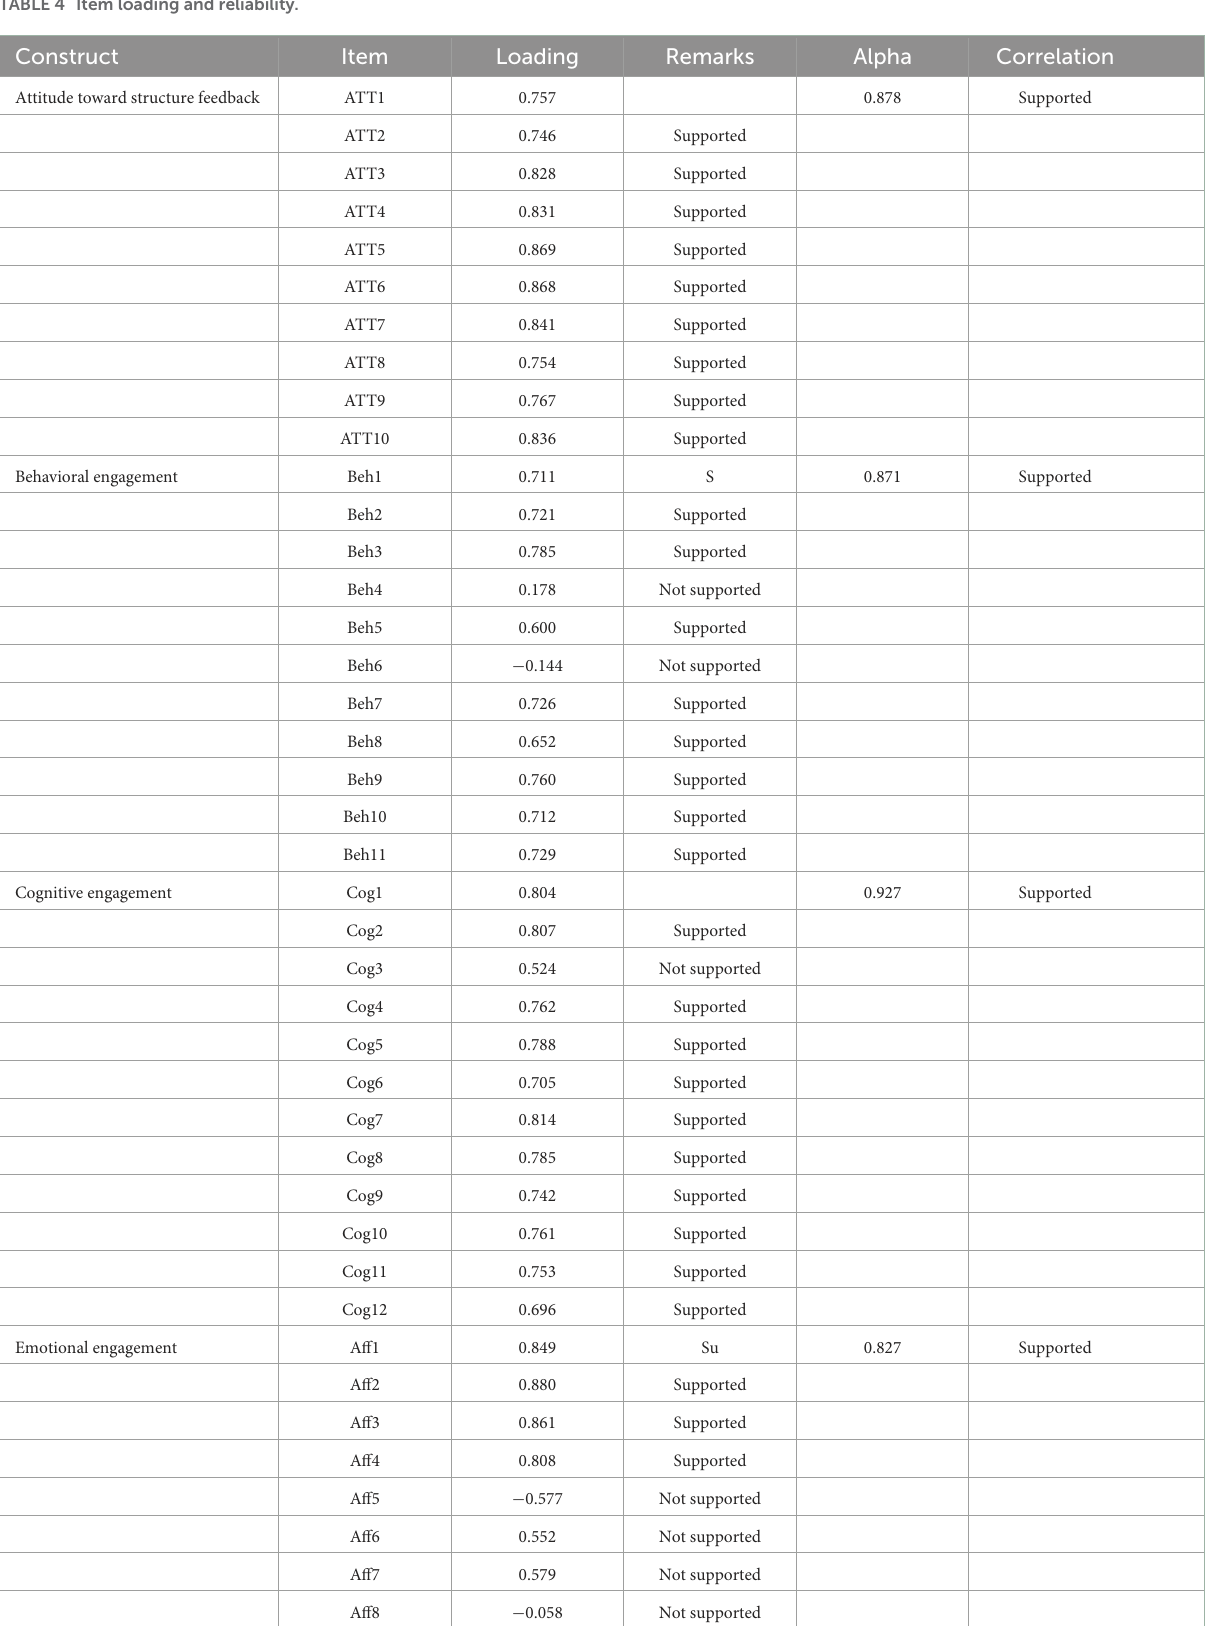
TABLE 4 Item loading and